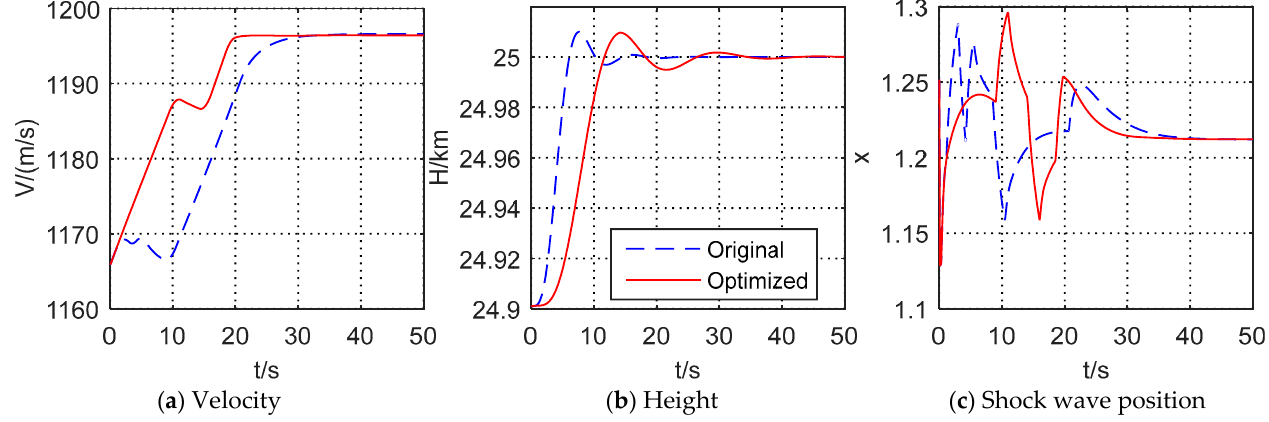
Figure 6. Comparison before and after controller’s optimization of the climb.